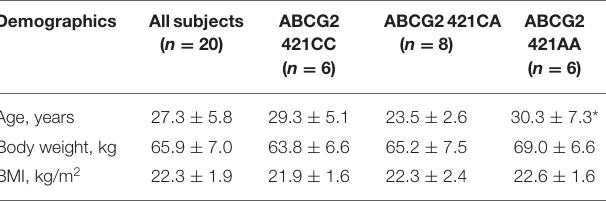
TABLE 1 | Demographics of the 20 study subjects in the rosuvastatin-herb interaction study. Demographics